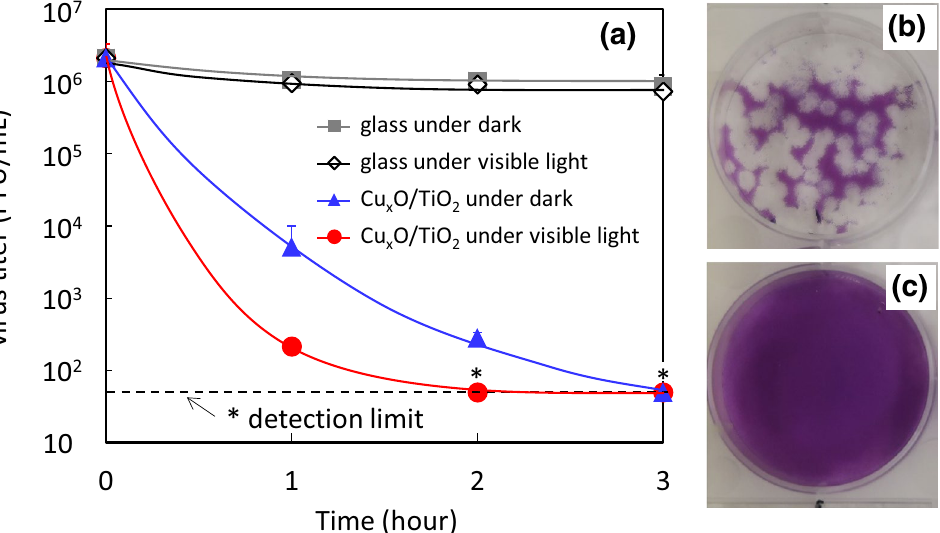
Figure 2. Inactivation of wild-type strain of SARS-CoV-2 by photocatalyst. ( a ) changes of virus titer of SARS- CoV-2 (wild-type strain, 2019-nCoV JPN/TY/WK-521) for each condition, ( b ) photograph of viral plaques infected by SARS-CoV-2 for a bare glass substrate under visible light irradiation, and ( c ) photograph of viral plaques infected by SARS-CoV-2 for Cu x O/TiO 2 photocatalyst under visible light irradiation. White spots in photos indicate the active SARS-CoV-2 virus. Visible light irradiation was conducted using a white fluorescence bulb passed through a UV cutoff filter with the light intensity of 1000 lx. Asterisk marks (*) and dashed line in the panel ( a ) indicate detection limit of the